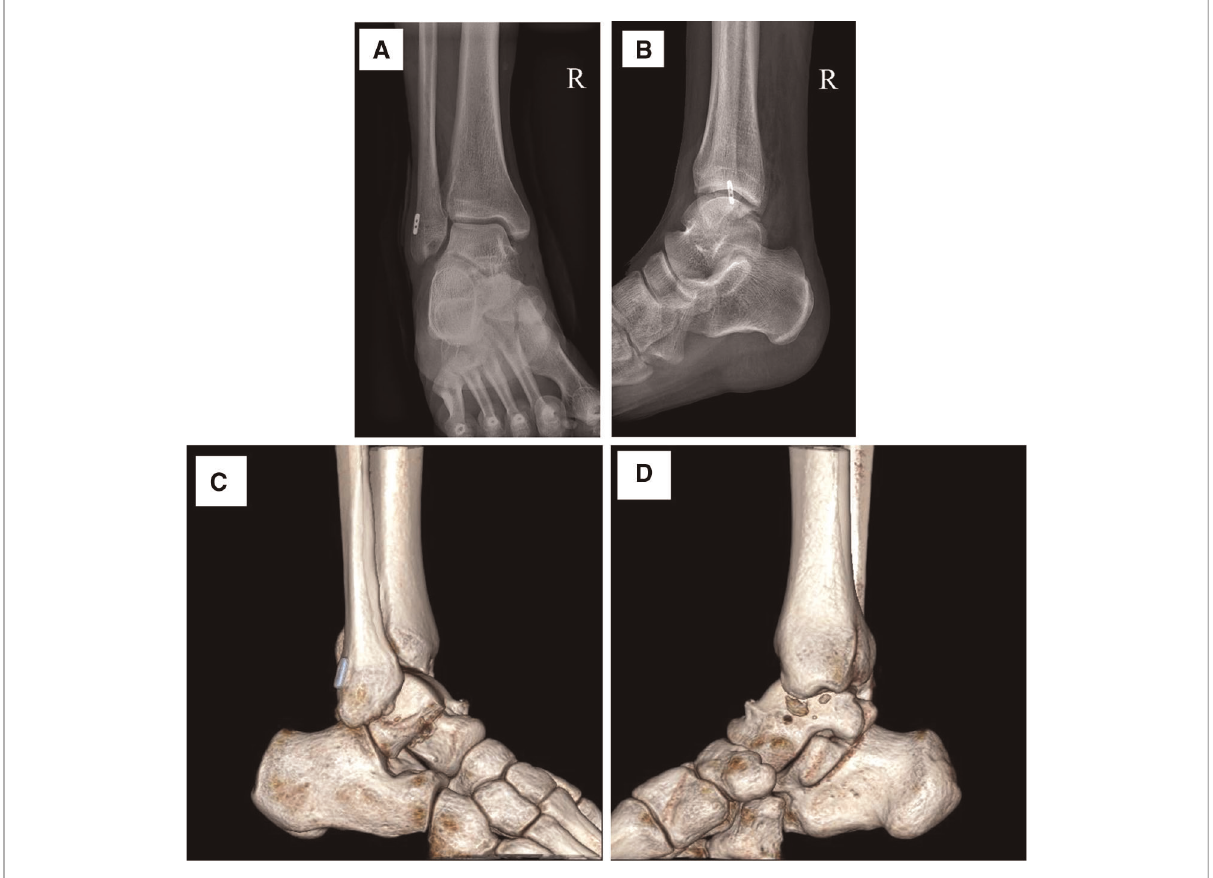
FIGURE 2 A typical case of the anterior talo fi bular ligament injury after anatomical reconstruction with autologous half-bundle peroneal longus tendon. ( A ) Post-operative X-ray image in the anterior position. ( B ) Post-operative X-ray image in the lateral position. ( C,D ) Post-operative CT reconstruction image in the sagittal